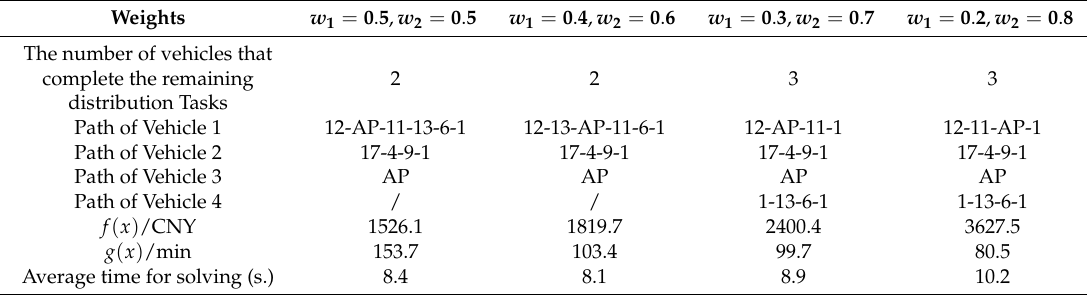
Table 6. Results under different objective